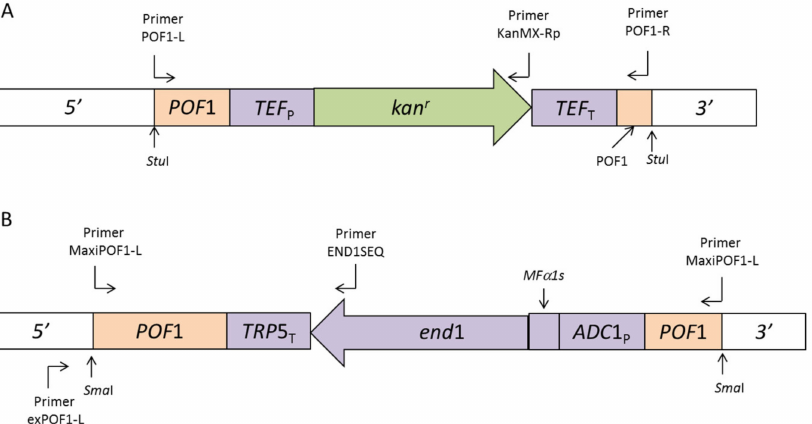
Figure 1. ( A , B ) Schematic presentation of the integration cassettes prepared for the disruption of the POF1 gene, through the exploitation of the homologous recombination system of yeast, on the genomes of VIN13 and PR7. The primer alignment positions of POF1-L and -R as well as MaxiPOF1-L and -R that were used to amplify the POF1 homologous regions are indicated on the diagram as well as the primers that were used to confirm the integration event at the intended position on the genome (exPOF1-L, MaxiPOF1-L and